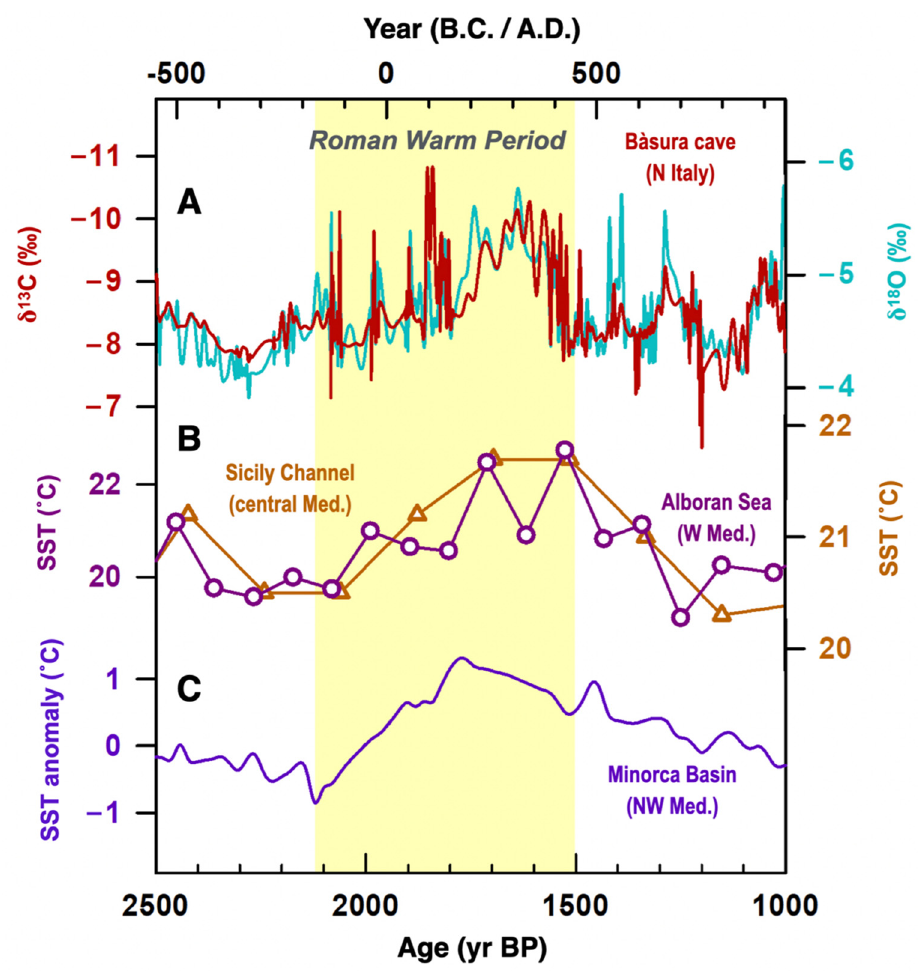
Figure 3. Comparison of Basura proxy and marine records in the Mediterranean Sea. ( A ) Basura BA14-1 δ 13 C (dark red) and δ 18 O (tiffany blue) records. ( B ) Sea surface temperature (SST) records. Brown: SW104-ND11, Sicily Channel [19]. Dark purple: TTR17-434G, Alboran Sea [25]. ( C ) SST anomaly record from MINMC06 and HER-MC-MR3, Minorca Basin [27]. The yellow bar indicates the interval of the Roman warm period from 200 B.C. to 400 A.D.